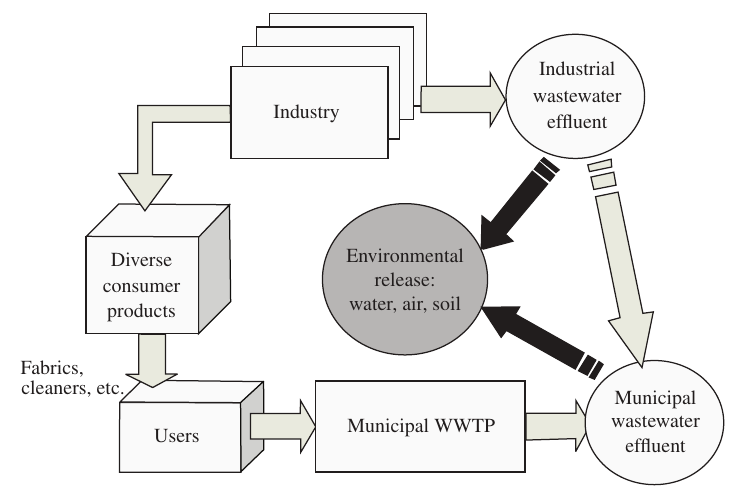
FIGURE 5: Conceptualization of proposed emission inventory